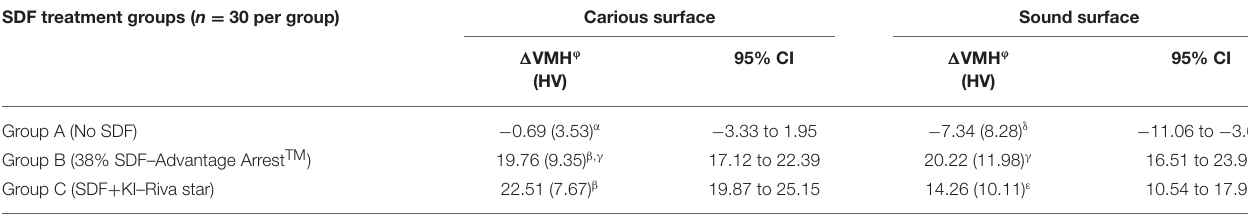
TABLE 1 | Change in microhardness [Mean (Std. Dev.)] based on type of surface assessed and type of SDF treatment. SDF treatment groups ( n = 30 per group)